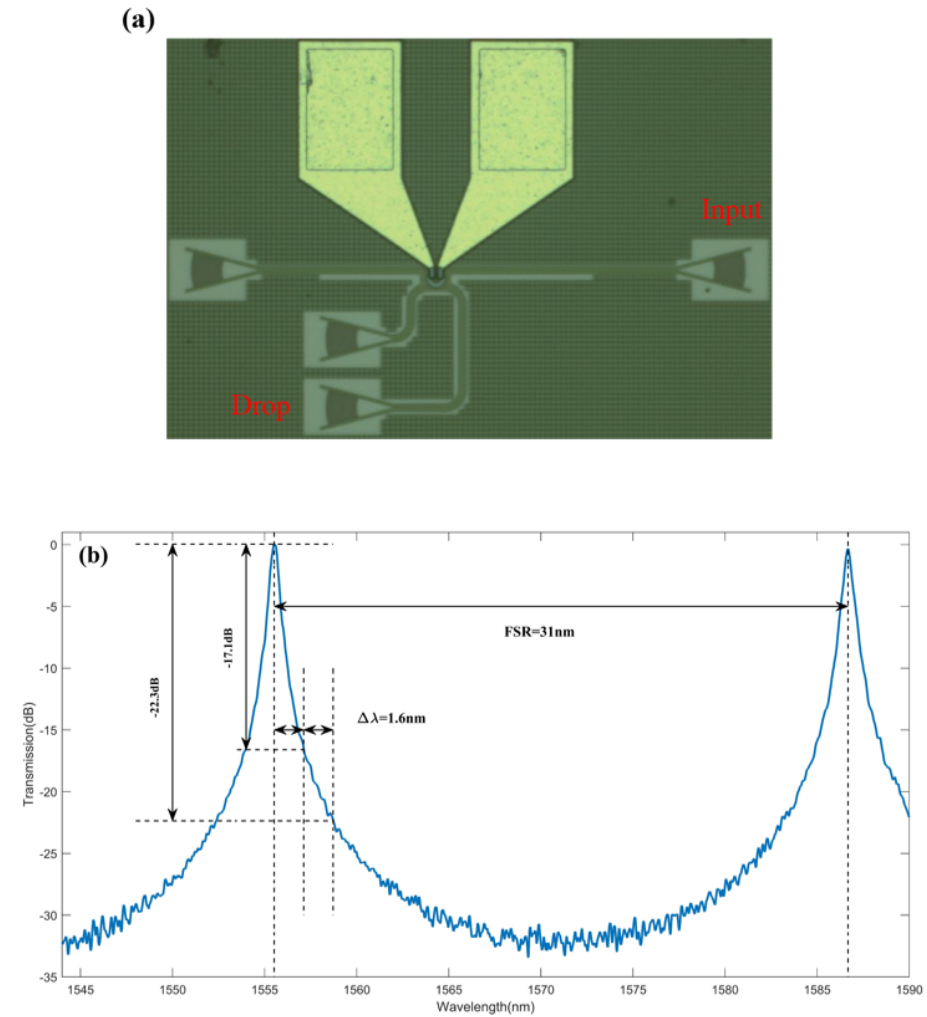
Figure 5. ( a ) Microscope image of the fabricated MRR, ( b ) measured spectral response of an MRR. After signals were demultiplexed from the i -th output ports of MDM, all wavelength channels were demultiplexed by the MRRs and dropped to the ports O i _ j ( j = 1, 2..., 16 ) . The transmissions of the hybrid MDM–WDM (de)multiplexer were characterized by mea- suring the spectral responses at each port O i _ j with light injected from I i . We utilized a broad bandwidth light source (1460 nm ∼ 1620 nm) and a polarization controller to obtain TE-polarized incident light. Figure 6 shows the normalized transmission responses by an optical spectrum analyzer. The fabricated device can be used in a broad wavelength range from 1493 nm to 1583 nm. It can be seen that three FSRs of the hybrid MDM–WDM (de)multiplexer were covered, which had an excess loss below 3.9 dB within one FSR from 1522 nm to 1552 nm and below 5.6 dB in three FSRs from 1493 nm to 1583 nm.